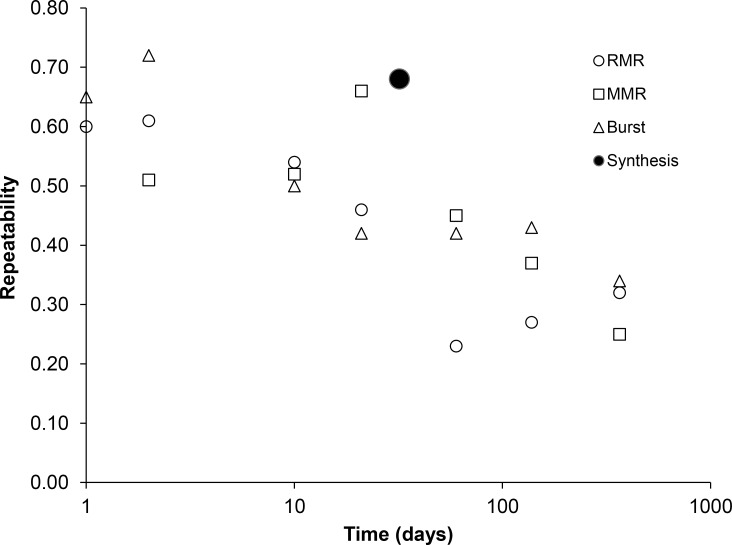
Temporal changes in repeatability of physiological performance.The effect of increasing time interval between repeat measures on the broad sense repeatability of routine metabolic rate (RMR), maximum metabolic rate (MMR) and burst locomotor performance (Burst) plus an estimate of broad sense repeatability for absolute rates of protein synthesis over 32 days calculated from the results of the present study. Metabolic rate data are derived from S1 Table of White et al. [10] and locomotor performance data are derived from S2 Table of Laming et al. [8] respectively and are presented as average values for the following time intervals: < 1 day, 1–2 days, 1–2 weeks, 2–4 weeks, 1–3 months, 3 months– 1 year and > 1 year. These data are plotted on the abscissa as values of 1, 2, 10, 21, 60, 138 and 365 respectively. Raw data used in the plot can be found in S1 File.